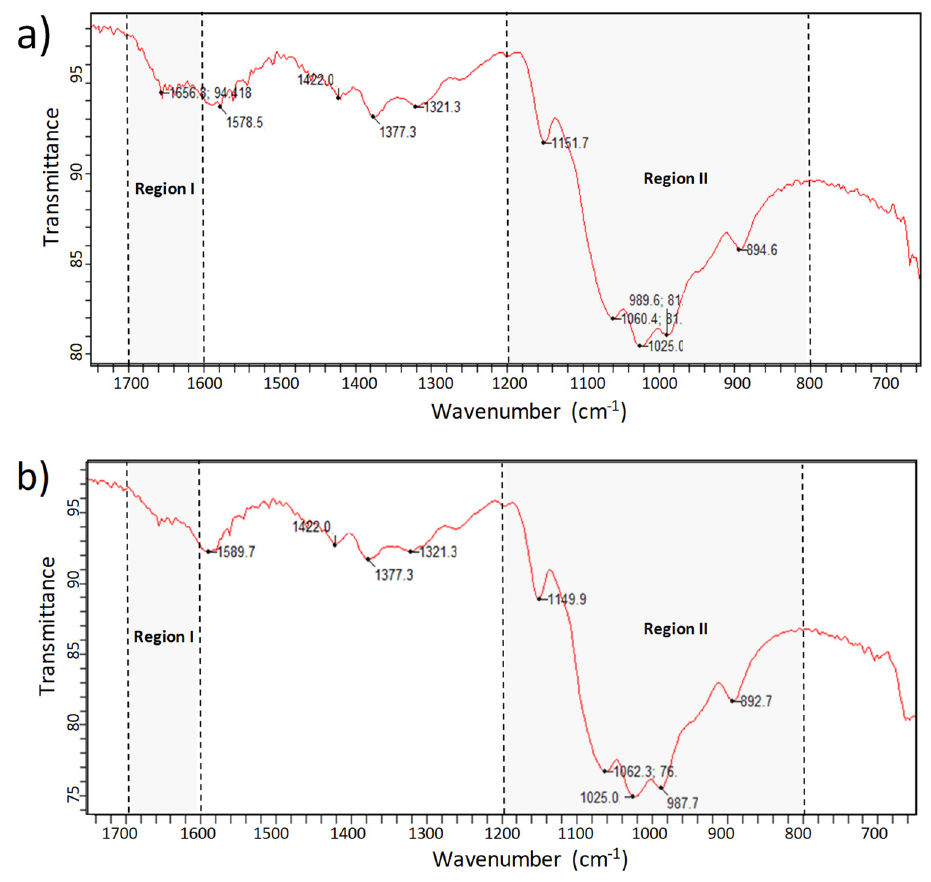
Figure 4. FTIR spectrum of ( a ) Chitosan-CGNA; and ( b ) commercial